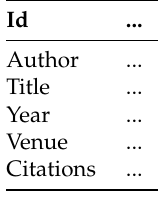
Table 7. Data Extraction Form—part 1.